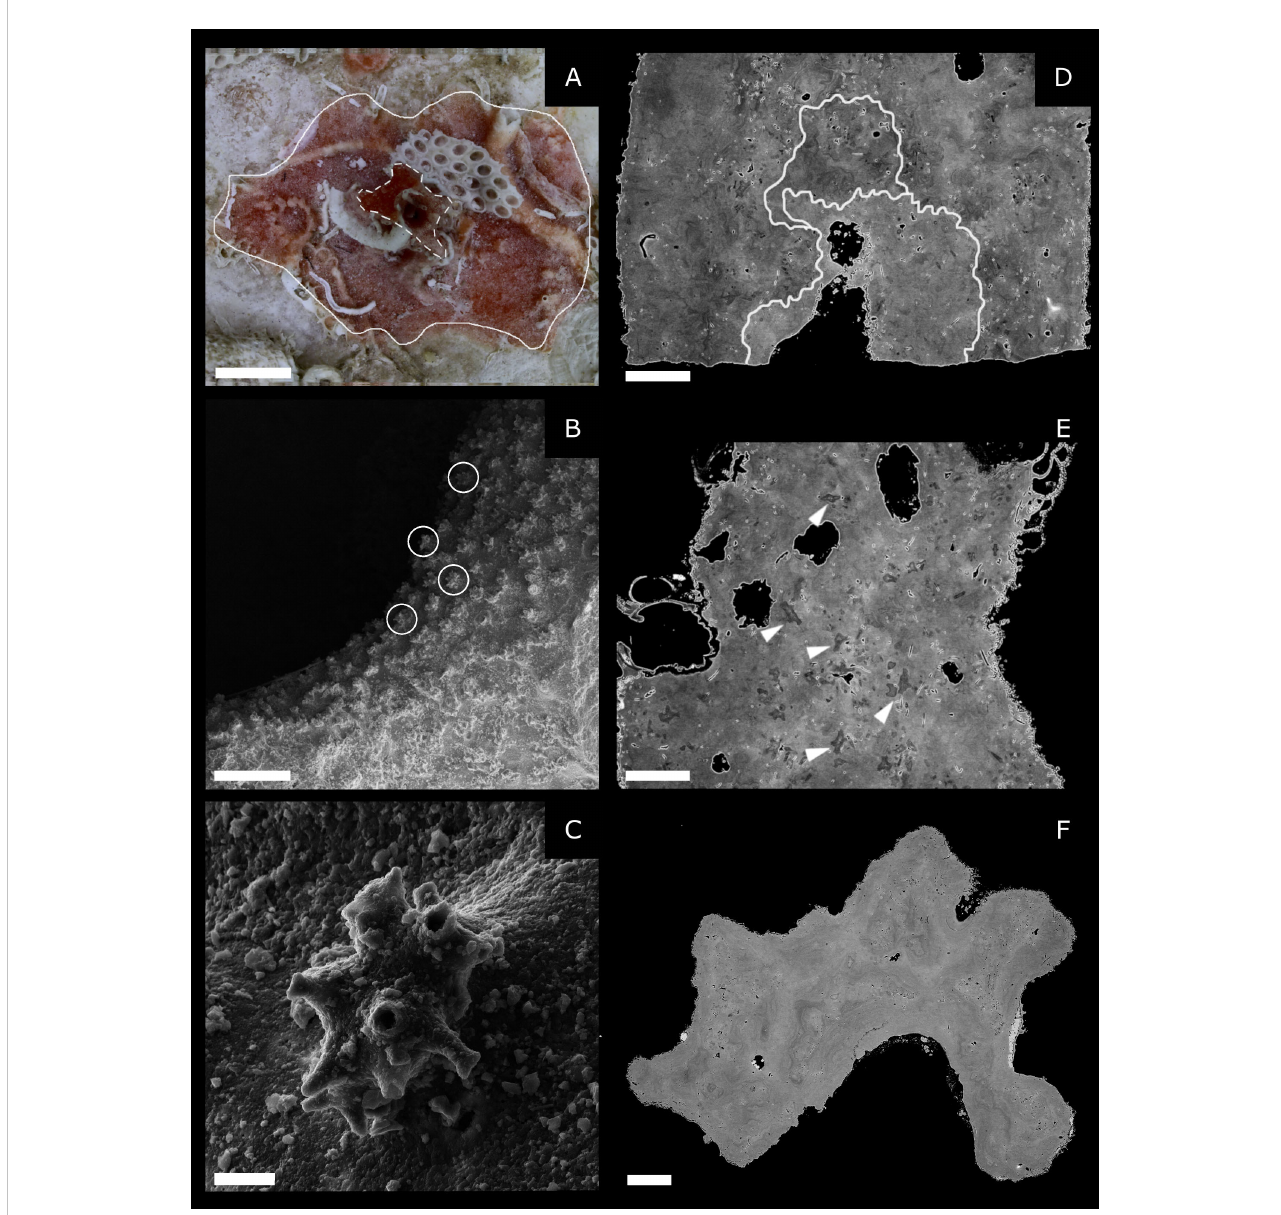
FIGURE 5 3- to 4-year-old samples. (A) Stereomicroscope top-down view showing the axial skeleton of the colony (dashed white lines) and the area constituted by diffused sclerites around it (continuous white line) (scale bar 2 mm). (B, C) Scanning electron microscopy: SE mode. (B) The colony ’ s surface with external micro- protuberances (circles) (scale bar 100 µm). (C) blow-up on a single damaged but still recognizable micro-protuberance (scale bar 5 µm). (D, E) Longitudinal sections of the axial skeleton of 3- to 4-year-old samples observed by SEM in BE mode (polished sample). The white line indicates the calcitic layers forming the skeleton. White arrows indicate sclerites embedded in the cement (scale bar 200 µm). (F) Transversal section of the axial skeleton of a 3- to 4-year-old sample observed by SEM in BE mode (polished sample). No visible annular rings is observed (scale bar 200